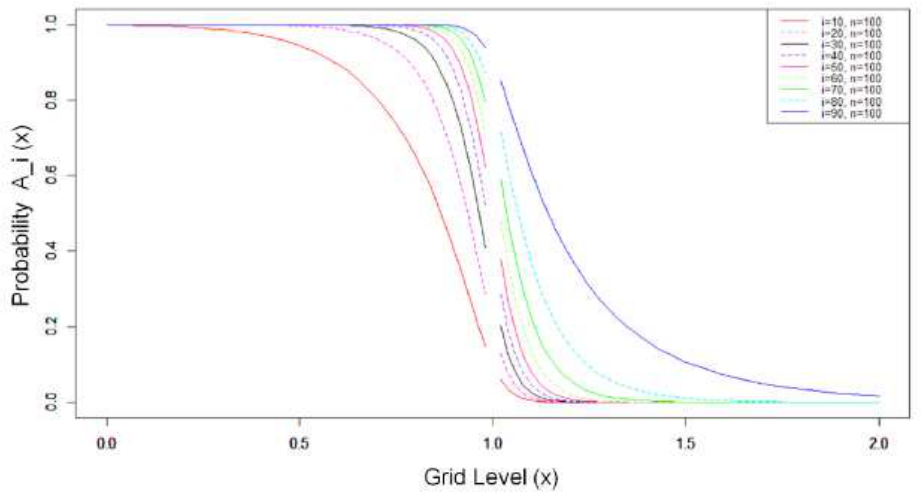
Figure 4. GTP transition probabilities of ( ) ( with P Q